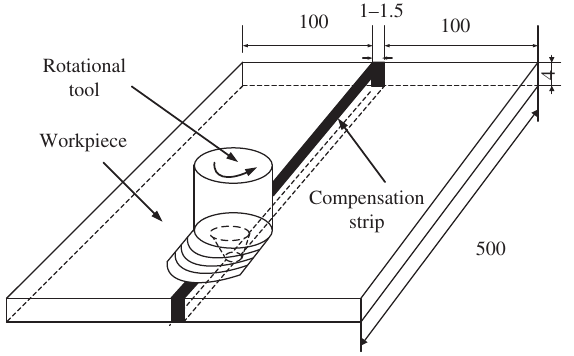
Figure 1: Schematic diagram of VCFSW process.